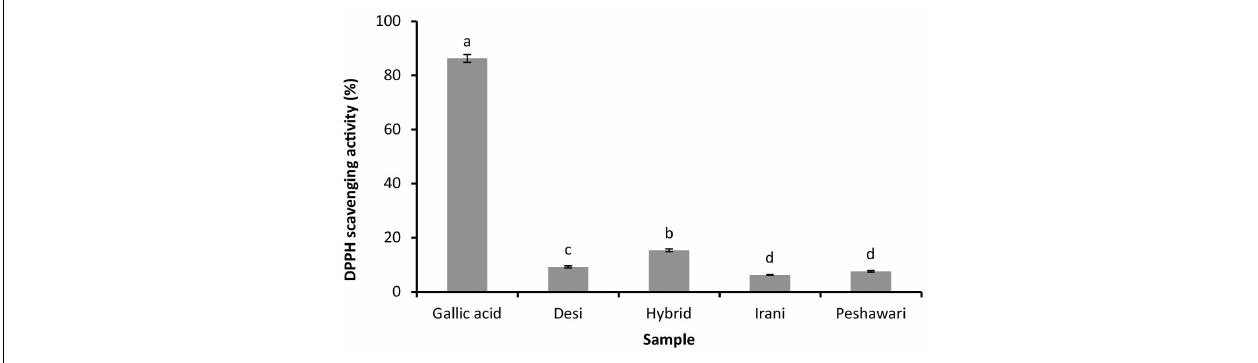
FIGURE 1 | Percent DPPH scavenging activity of essential oils from fresh leaves of four coriander cultivars and gallic acid (positive control). Data are expressed as the mean activity ± standard deviation ( n = 3). The bars labeled with different letters are significantly different ( P < 0.05) from each other when data analyzed by ANOVA post hoc Tukey